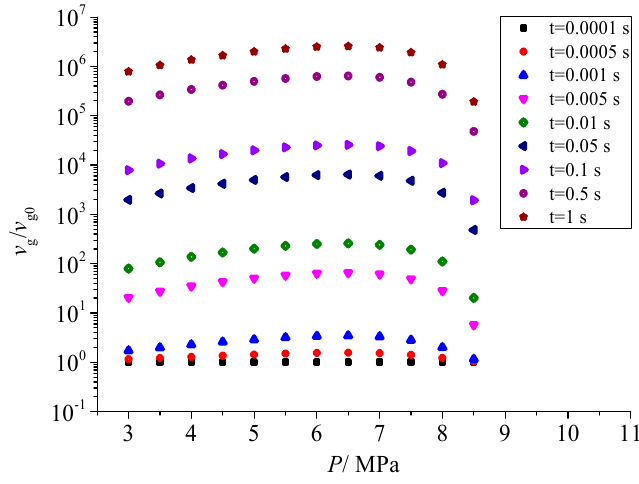
Figure 12. Effect of pressure on dimensionless geometric volume.